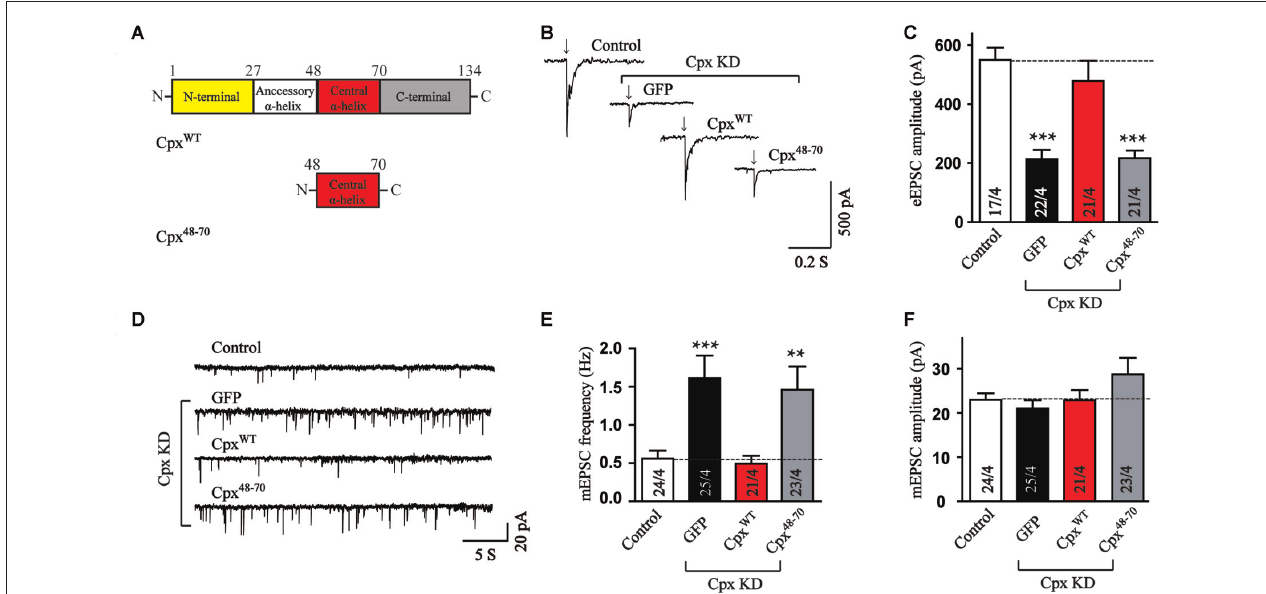
FIGURE 1 | The central α -helix alone cannot regulate neurotransmitter release. (A) Schematic structures of wild type (Cpx WT ) and central α -helix of Cpx (Cpx 48–70 ). (B,C) Sample traces (B) and summary graphs of the amplitude (C) of action-potential evoked AMPAR-mediated EPSCs monitored in cultured cortical neurons that were infected with a control lentivirus (control) or lentiviruses expressing complexin shRNAs (GFP) without or with coexpression of Cpx WT or Cpx 48–70 , respectively. (D–F) Sample trace (D) and summary graphs of the frequency (E) and amplitude (F) of miniature excitatory postsynaptic currents (mEPSCs) recorded in neurons as described for (B) . Data shown in summary graphs are means ± SEM; numbers of cells/independent cultures analyzed are listed in the bars. Statistical assessments were performed by the Student’s t -test comparing each condition to the indicated control experiment ( ∗∗ p < 0.01, ∗∗∗ p <